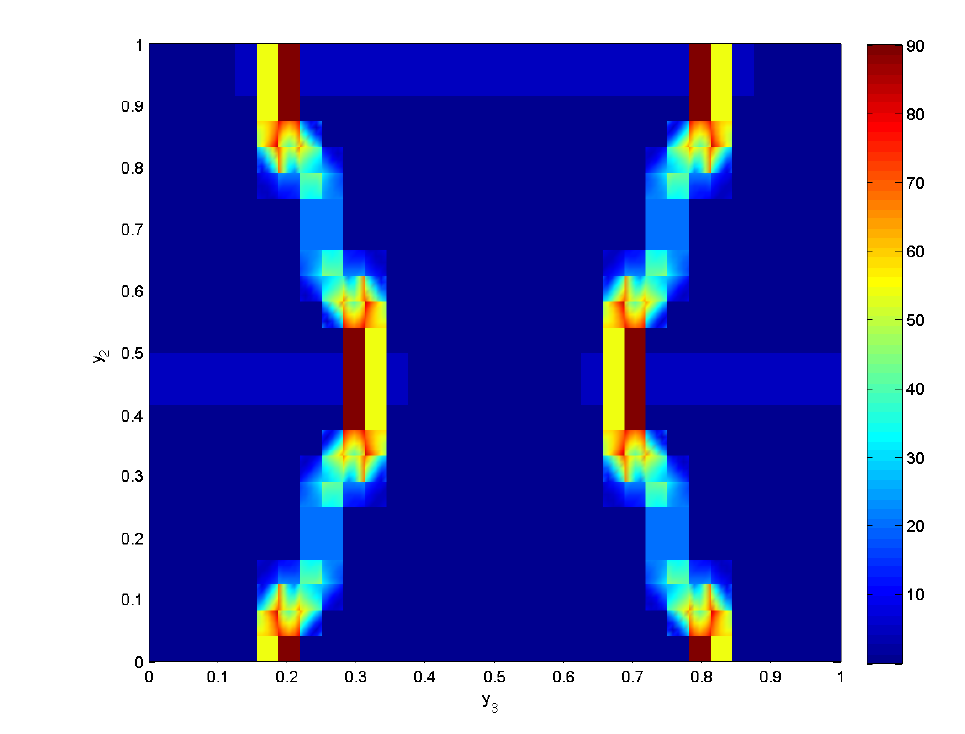
Figure 10. The von Misses stress distribution over the re-entrant repeating unit cell of aluminum with voids with θ = 75 ◦